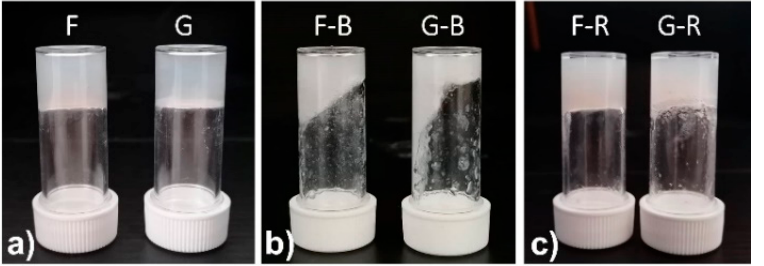
Figure 5. Thixotropy tests of samples F and G : ( a ) samples after formation ( F , G ); ( b ) samples after break ( F-B , G-B ); ( c ) samples after overnight recovery ( F-R , G-R ).